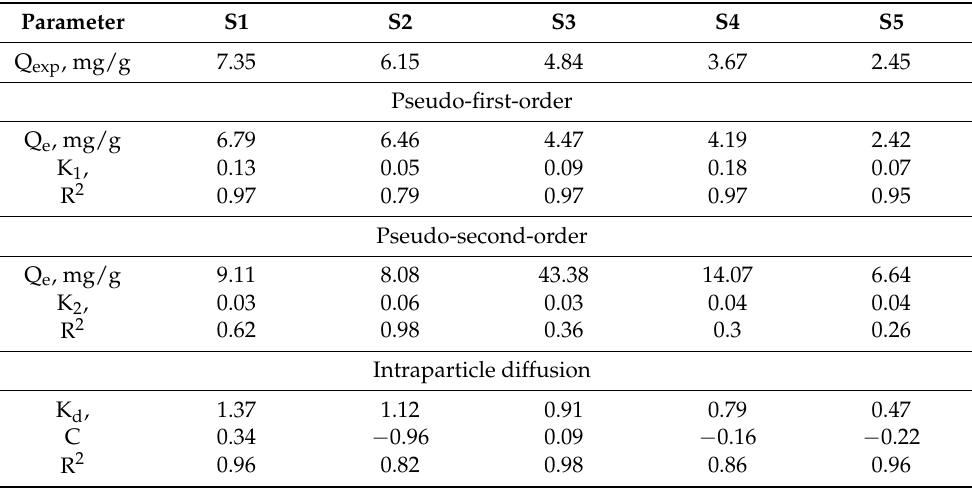
Table 4. Kinetics parameters of Rhodamine B dye sorption onto the obtained samples (Q exp is the amount of adsorbed dyes obtained from experimental